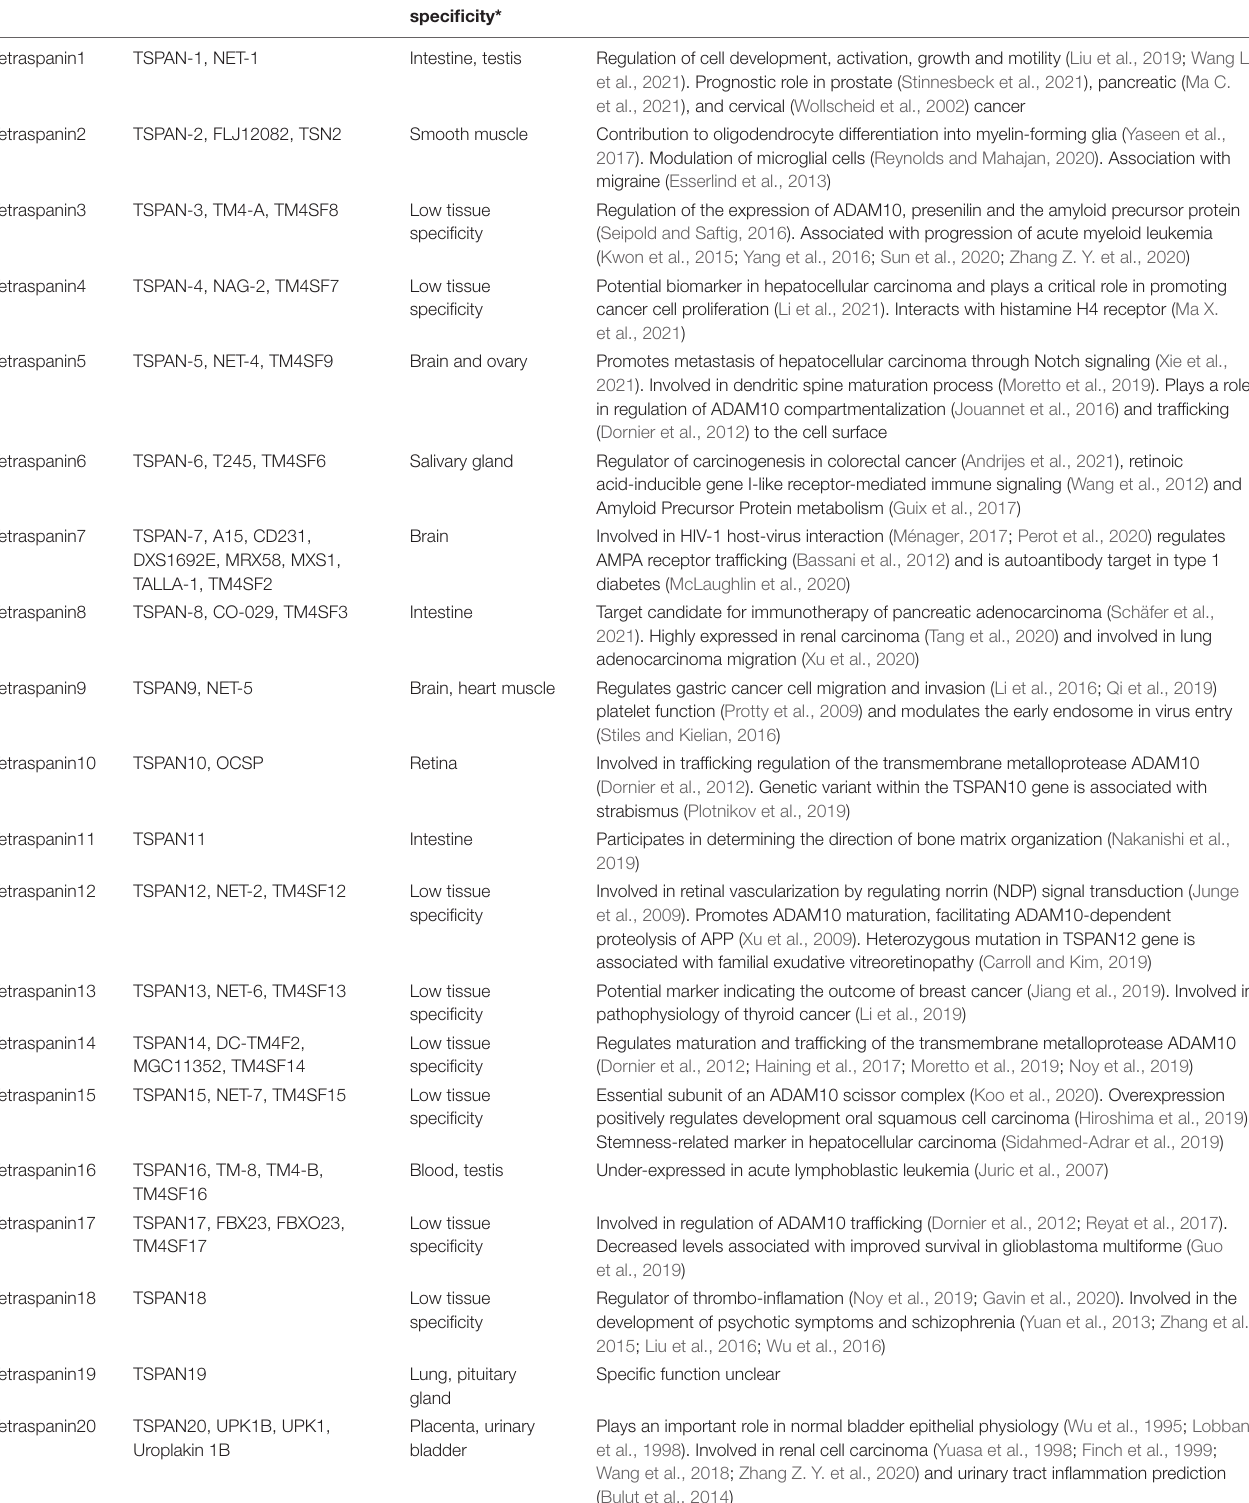
TABLE 1 | Summary of human tetraspanins with their alternative names, tissue specificity and the